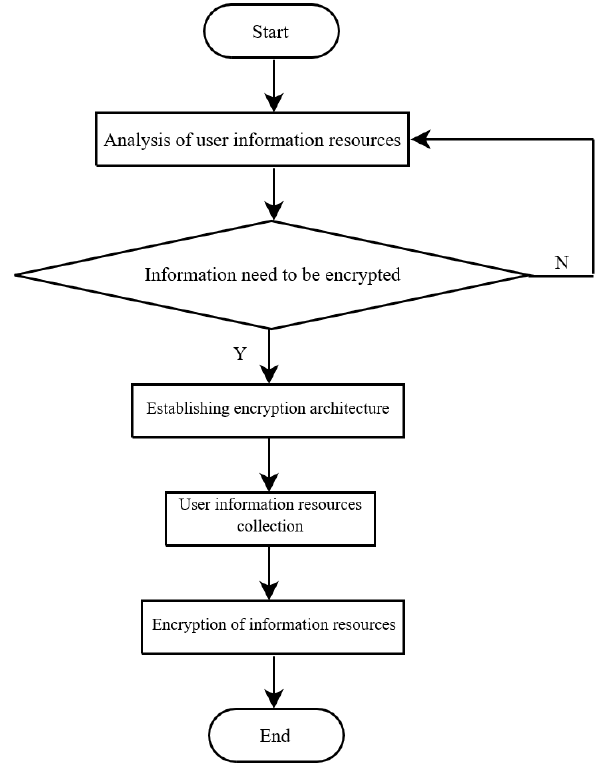
Figure 1. Secure encryption algorithm flow